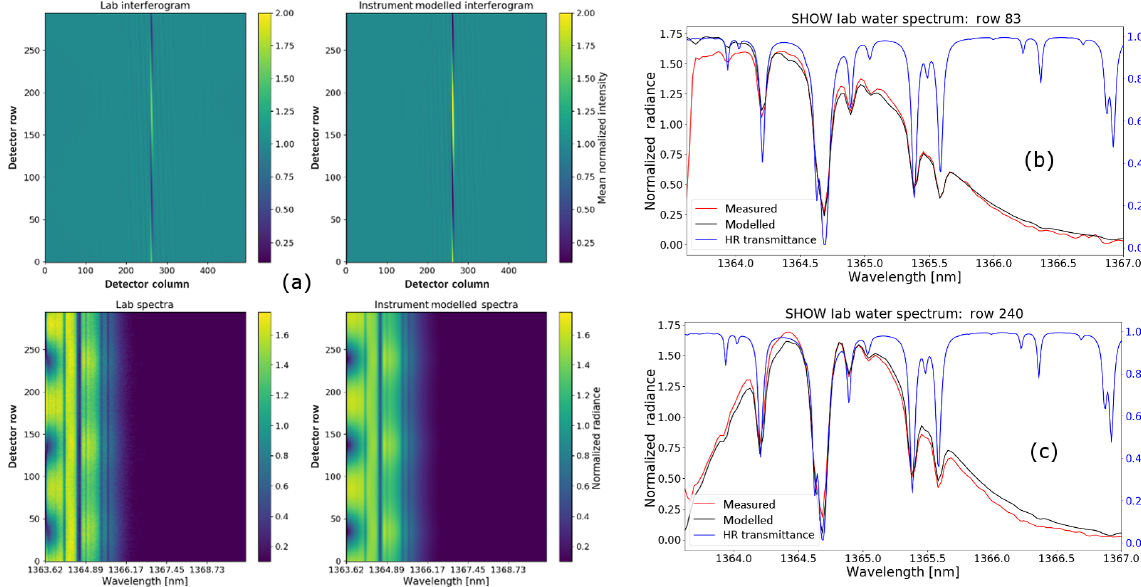
Figure 8. Instrument model optimization using laboratory data. Comparison between the modelled and measured interferograms and spectral images (a) . Example spectral row cuts at row 83 (b) and at row 240 in (c) . The measured spectrum is shown in red and the modelled spectrum is shown in black. The normalized high-resolution spectrum that was utilized in the instrument model is shown in blue.